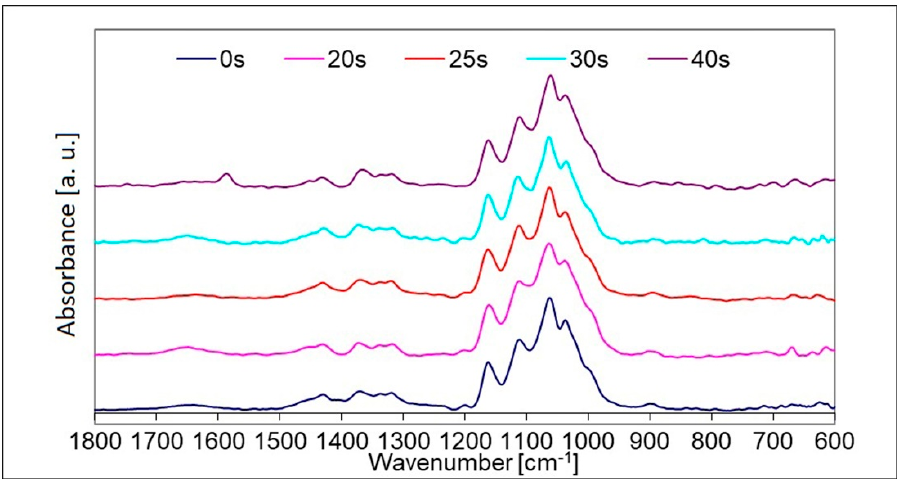
Figure 6. Infrared spectra recorded in the region 600–1800 cm − 1 for cotton fibres of Sample 2 (CO 79/PES 21) subjected to heat radiation (10 kW/m 2 ) for various exposure times.